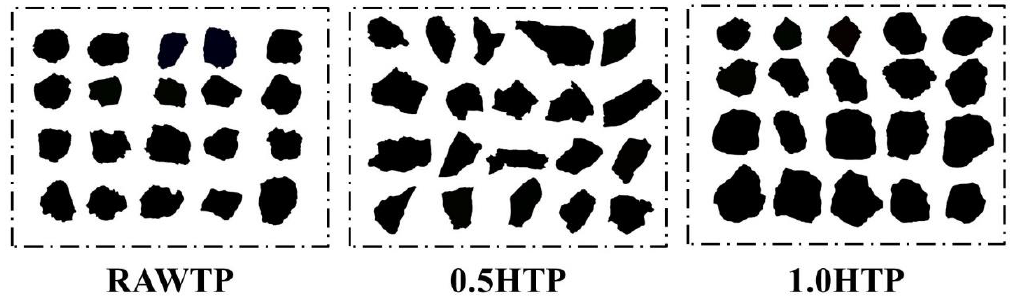
Figure 5. The morphological patterns of RAWTP, 0.5HTP, and 1.0HTP.